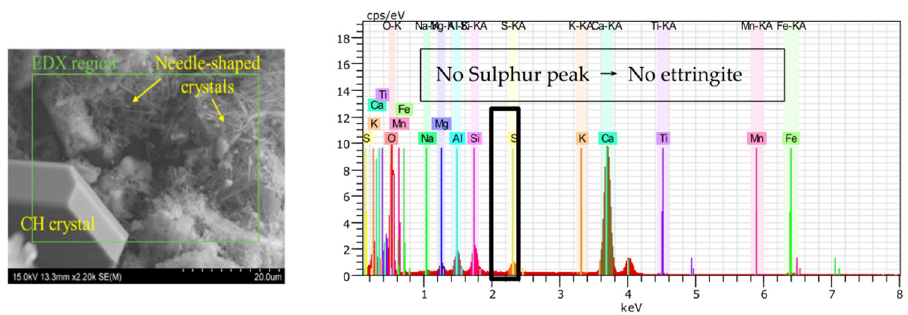
Figure 4. SEM-EDS analysis of needle-like products [64].